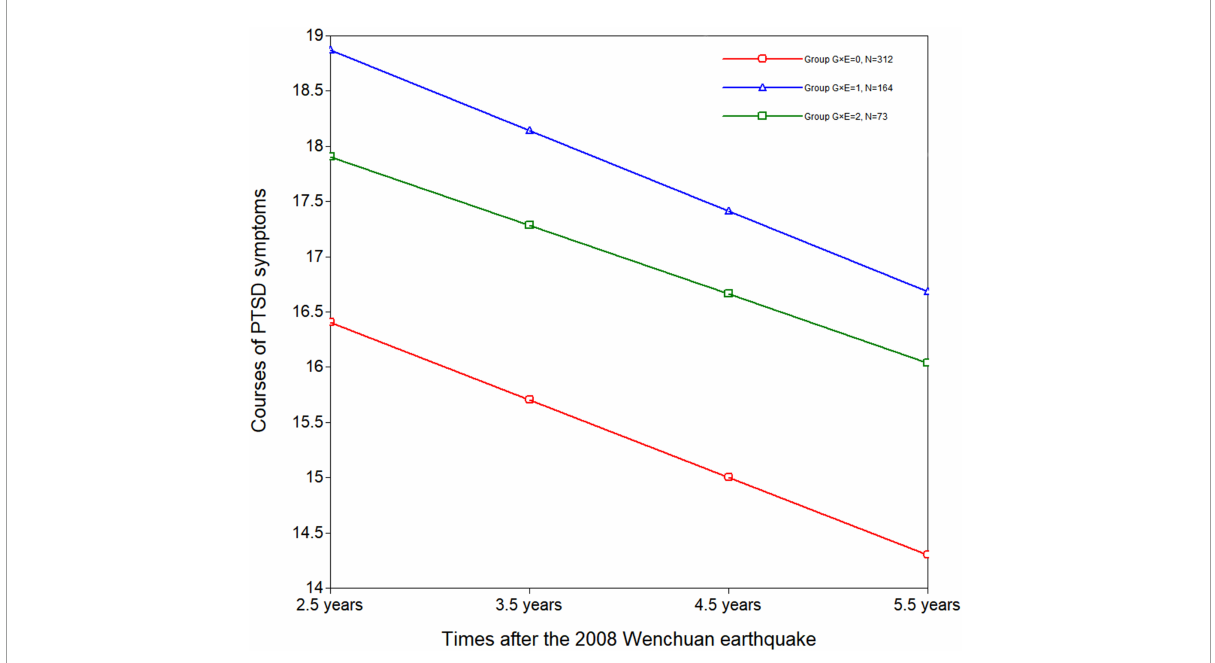
FIGURE1 Courses of PTSD symptoms between 2.5 and 5.5 years after the 2008 Wenchuan earthquake by G × E (rs2267735 × trauma exposure) interaction in girls. 0: n = 312; G × E = 1: n = 164; G × E = 2: n = 73.